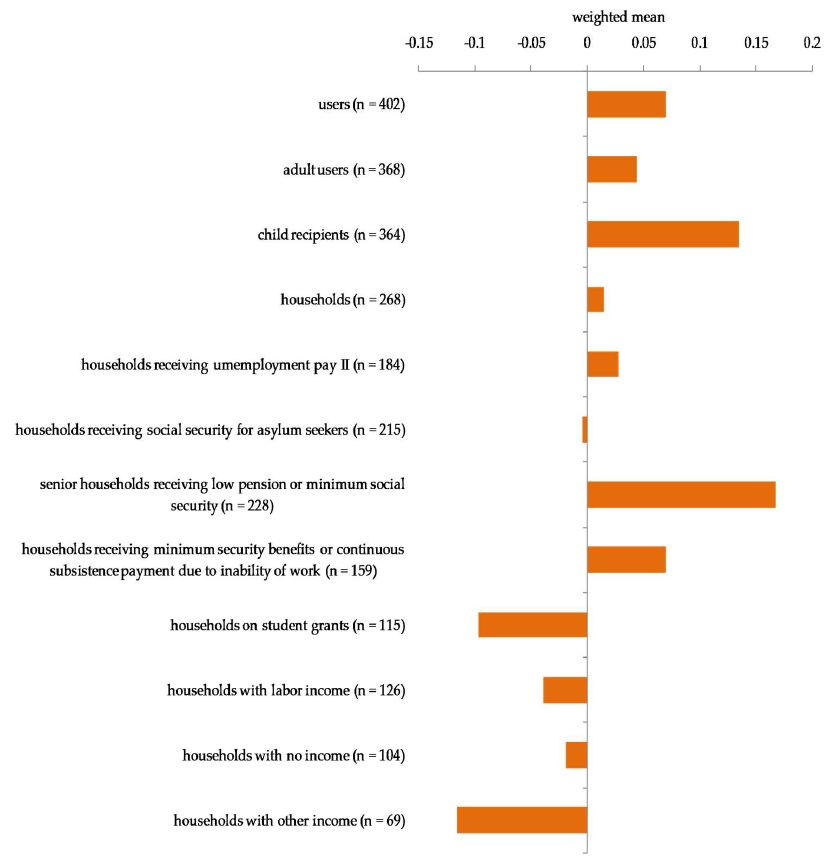
Figure 3. Number of users of participating food banks per month in 2017 compared with 2016 on a five-point scale.